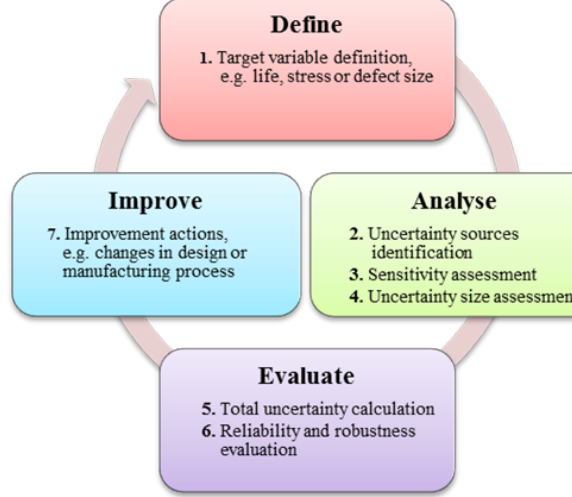
Fig. 3. VMEA in the design and improvement cycle. From